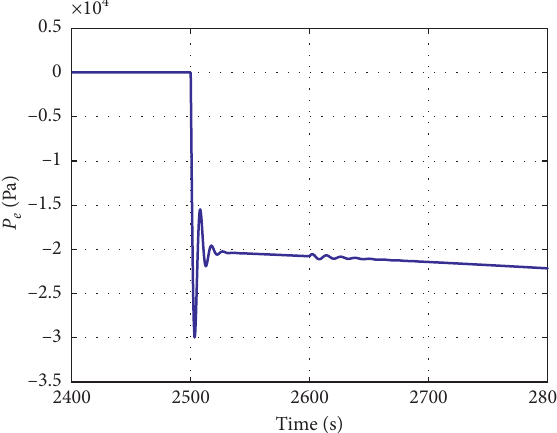
Figure 11: Pressure error caused by the sequential double